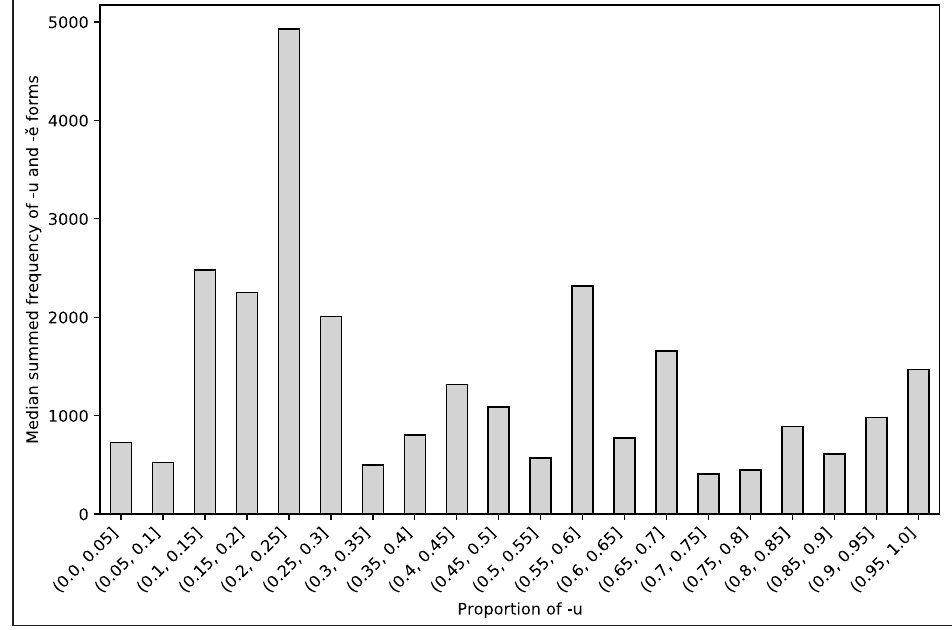
Figure 2 Median frequency of overabundant lexemes in the loc.sg for different bands of proportion of - u